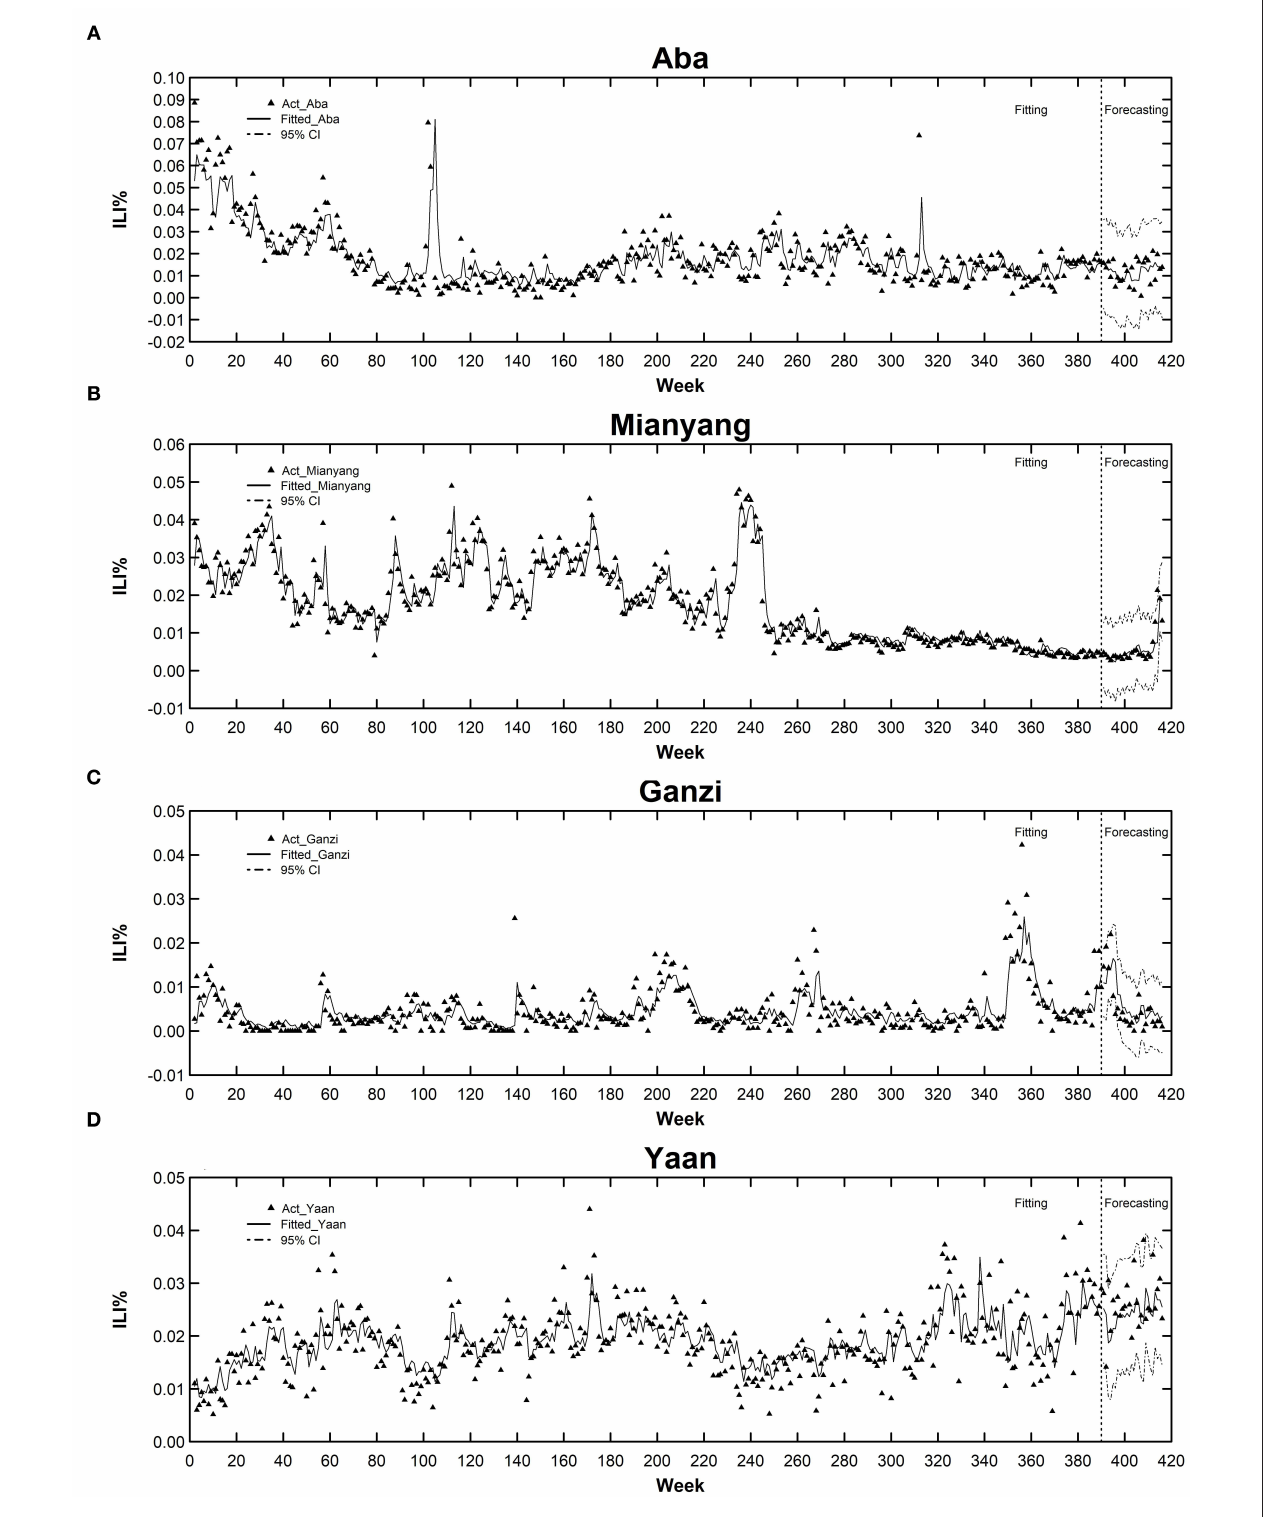
FIGURE 3 | The fitted/forecasted time series vs. the actual values for cities of cluster 1. (A) Aba. (B) Mianyang. (C) Ganzi. (D) Ya’an.